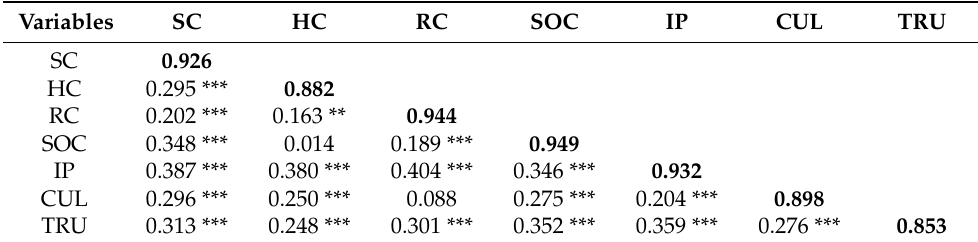
Table 4. Overall construct correlation of the measurement